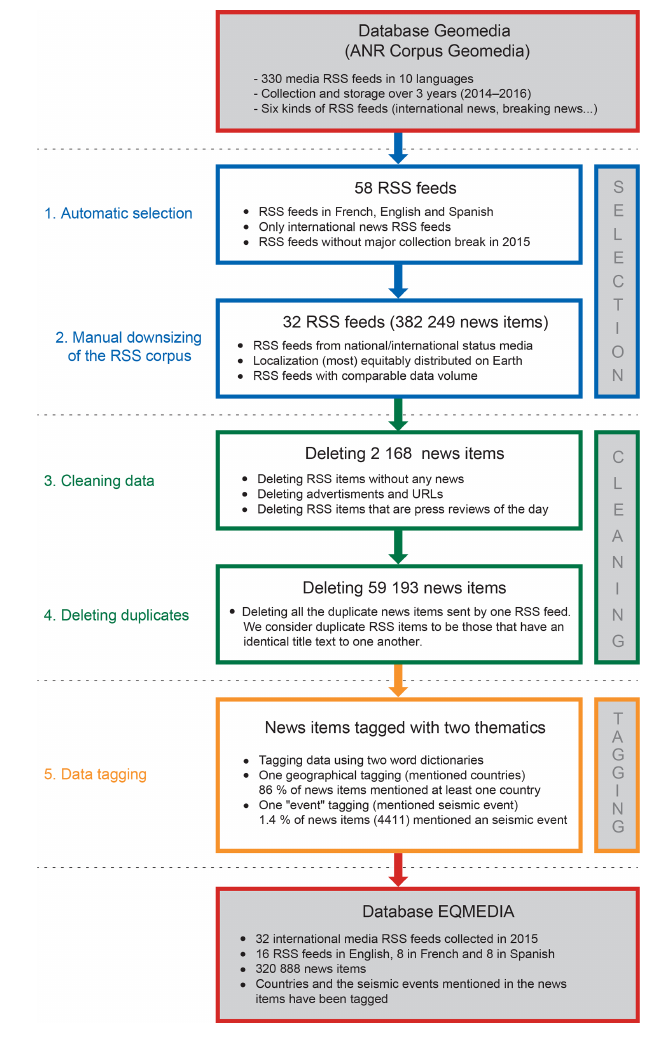
Figure 2. Building the EQMEDIA